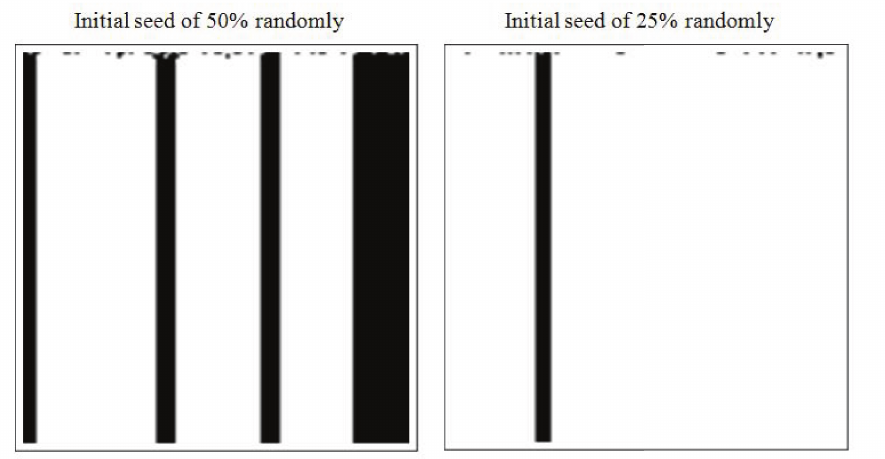
Figure 4. Eating behavior according to (36) - follow the majority: eat if at least 4 out of the neighborhood of 7 (radius r = 3 and totalistic) are obese. Assuming two states (0 = normal = white, 1 = obese = black) gives the cellular automaton rule #240. Simulations are for 100 agents (circular) and 100 time